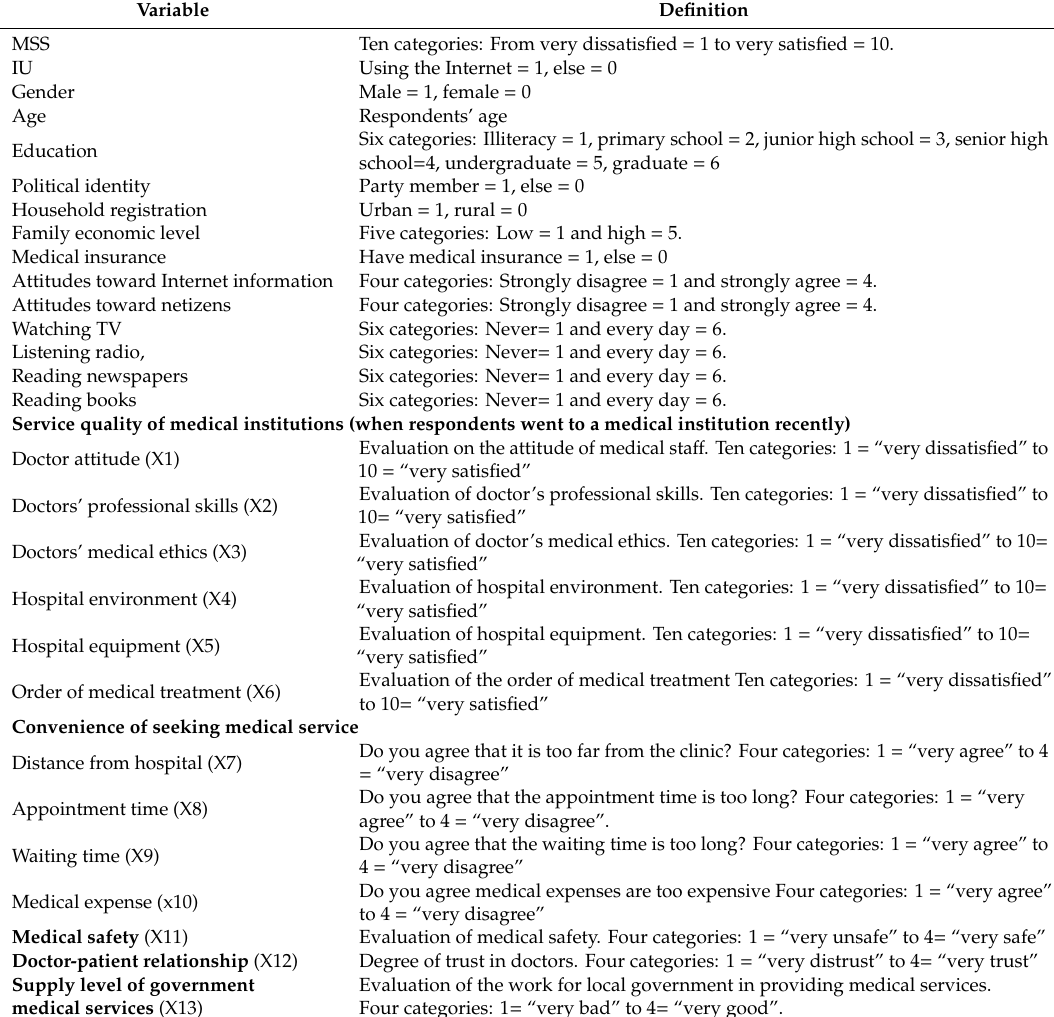
Table 1. Definition of